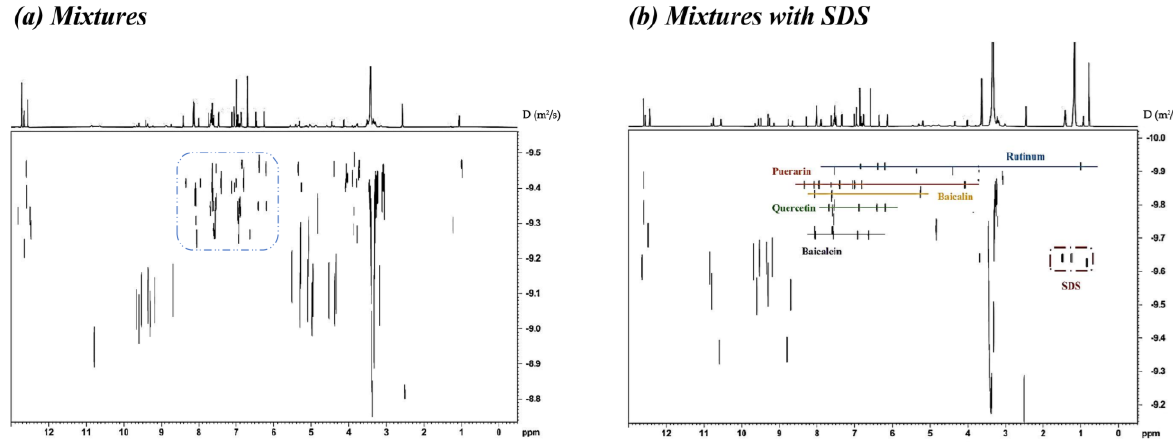
Figure 3. ( a ) DOSY spectra of the flavonoid mixture model (3 mg per analyte), ( b ) DOSY spectra of the same model after addition of 3 mg SDS, dissolved in 600 µ L DMSO– d 6 solution.